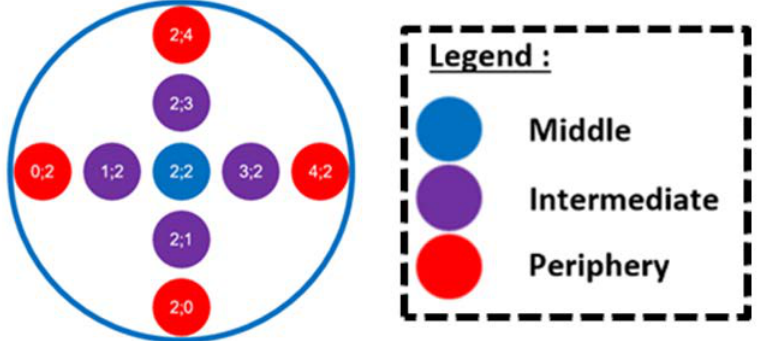
Figure 6. Reading pattern for the packaged membranes.